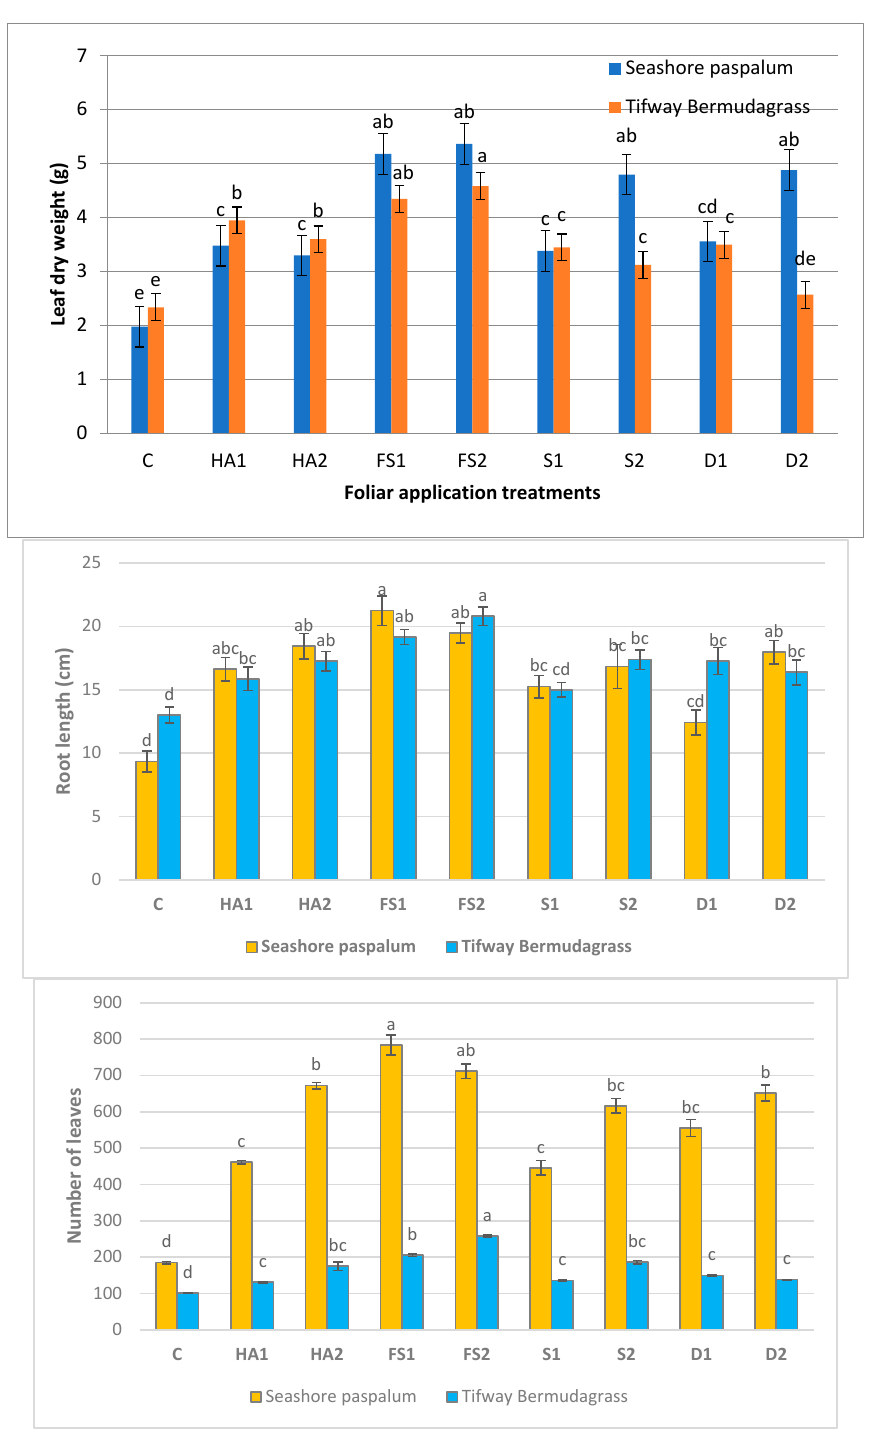
Figure 3. Mean values of leaf dry weight (g), root length, and number of leaves measured in January for the two species treated with different amendments obtained from combining the data from two seasons. C = control, HA = humic acid, FS = ferrous sulphate, S = silica, D = diatomite. For more details about the treatments used, please refer to Table 1. Values are presented as mean ± standard error of the mean, with the letter(s) from the species-wise Duncan’s multiple range tests indicated at the top of each bar. The area used for measuring the parameters was 100 cm 2